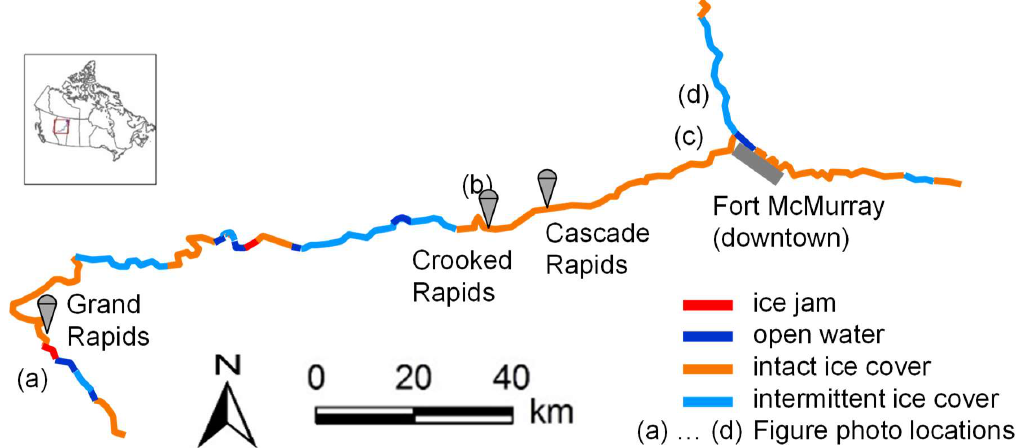
Figure 4. Ice map of the Athabasca and Clearwater rivers near Fort McMurray from 25 April 2018 (data source: [26]).